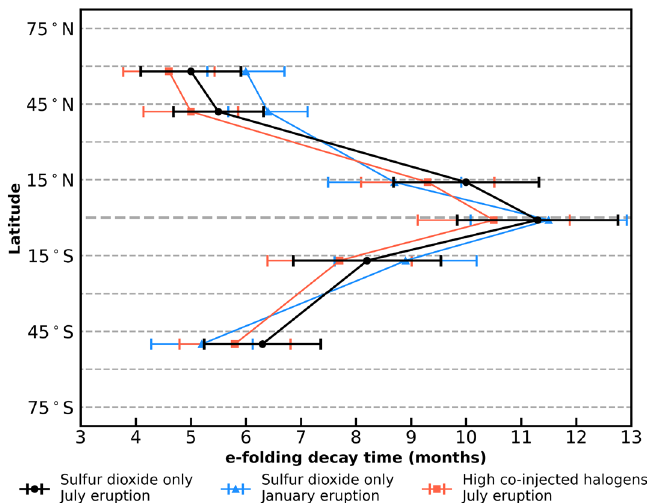
Figure 3. Average global sulfate aerosol e-folding decay time as a function of eruption latitude (SSP3-70 January/July 2025). Volcanic eruptions in January (blue) and July (black and red) 2025. The symbols indicate the volcanic stratospheric injection and season: 5 Tg SO 2 (sulfur dioxide only, black circles and blue triangles) and 5 Tg SO 2 , 0.5 Tg HCl, 0.005 Tg HBr (high co-injected halogens, red squares). The bars indicate the 2 σ variation of the model